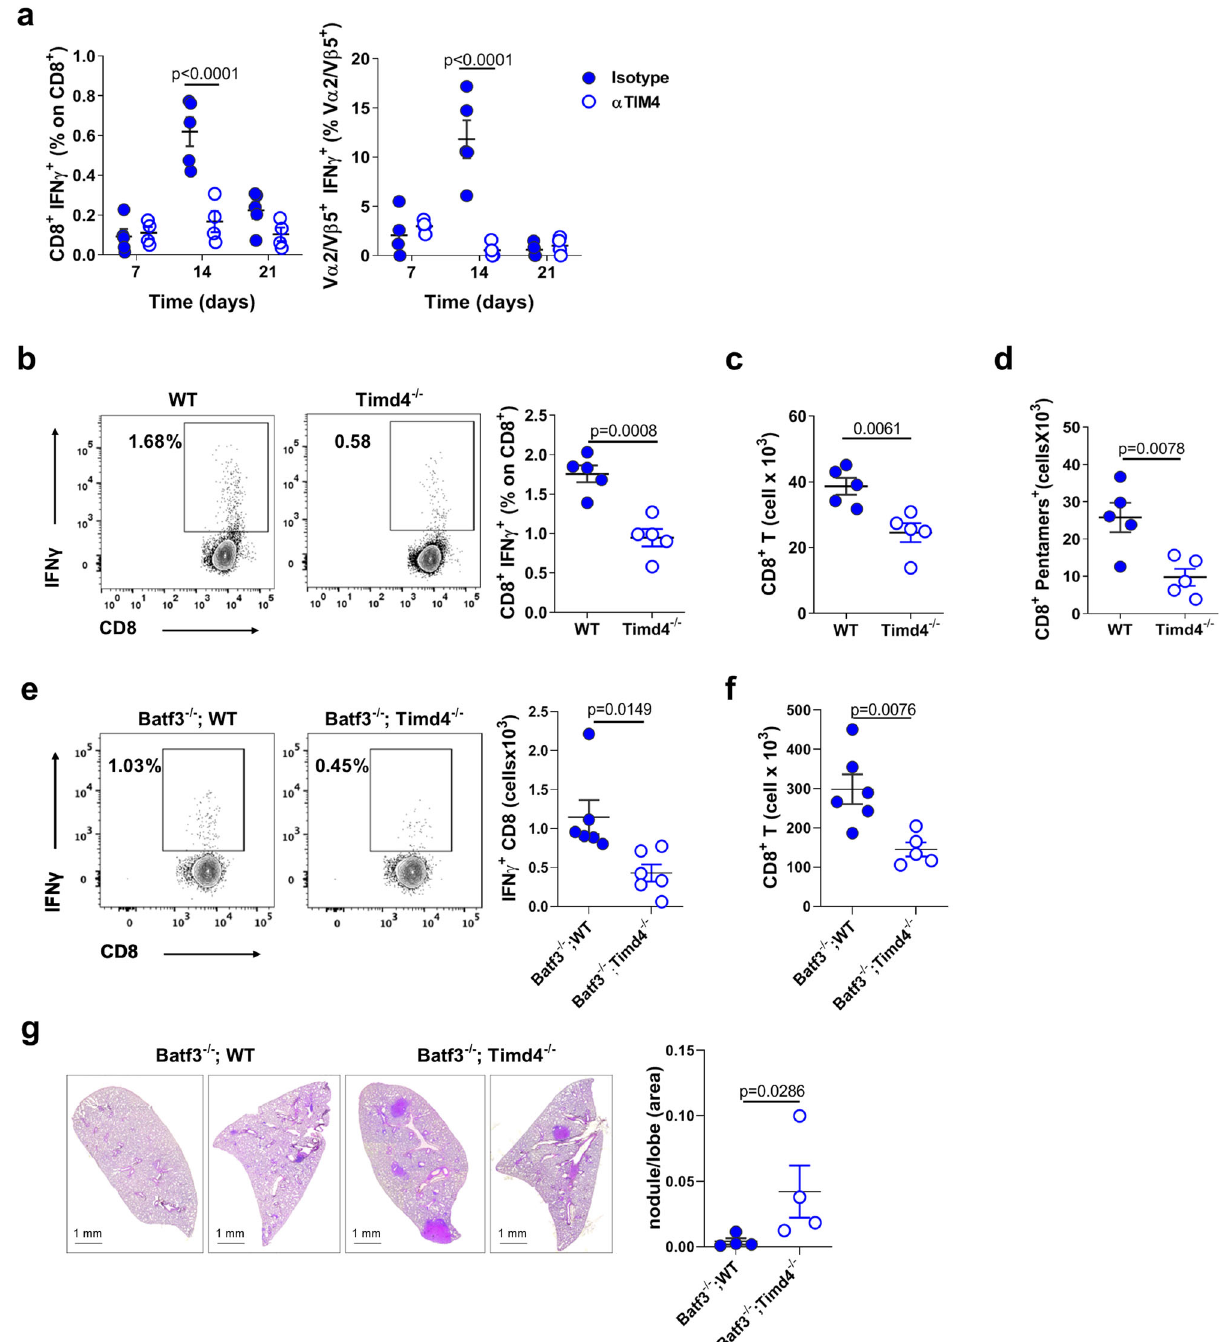
Fig. 5 TIM4 promotes anti-tumor CD8 + T cell responses and tumor control. a Effect of TIM4 blockade on activation of endogenous CD8 + T cells in the blood of KP-OVA challenged mice. The percentage of IFN- γ + CD8 and OVA speci fi c-IFN- γ + CD8 (V α 2/V β 5 + ) as a function of total CD8 and V α 2/V β 5 + T cells, respectively, at various time points after challenge. Isotype n = 5, α TIM4 n = 4, data represent one of two independent experiments. b – d Activation of anti-tumor T cell responses in WT and Timd4 − / − animals 7 days after challenge with KP-OVA. b Representative plots and frequencies of IFN- γ + endogenous CD8 + T cells in MLN. c Absolute numbers of CD8 + T cells and d OVA-speci fi c CD8 + T cells (pentamers + ) accumulated at tumor site. Data are representative of two experiments ( n = 5 mice/group). e – g Lethally irradiated CD45.1 WT mice were injected with a 1:1 mixture of CD45.2 bone marrows of the indicated genotypes to generate bone marrow chimeras. Ten weeks later mice were inoculated with KP-OVA tumors. e Representative plots and frequencies of IFN- γ + CD8 + T cells in MLN 10 days after tumor challenge ( n = 6 mice/group). f Absolute numbers and quanti fi cation of CD8 + T cells accumulated at tumor site with Batf3 − / − ;WT n = 6 and Batf3 − / − ;Timd4 − / − n = 5 mice. g Tumor growth in bone marrow chimeras was assessed 28 days after tumor challenge. Representative sections and quanti fi cation of tumor nodules calculated automatically on four consecutive sections of three lobes/animal and expressed as a function of the total lobe area. Each value in the plot represents the average of the three lobes and four sections for each mouse. All data are mean ± SEM. Signi fi cance was determined by two-way ANOVA followed by Sidak ’ s post-test for a , two-tailed unpaired t -test for b – f , and two-tailed Mann – Whitney test for g . Source data are provided as a Source Data fi le.